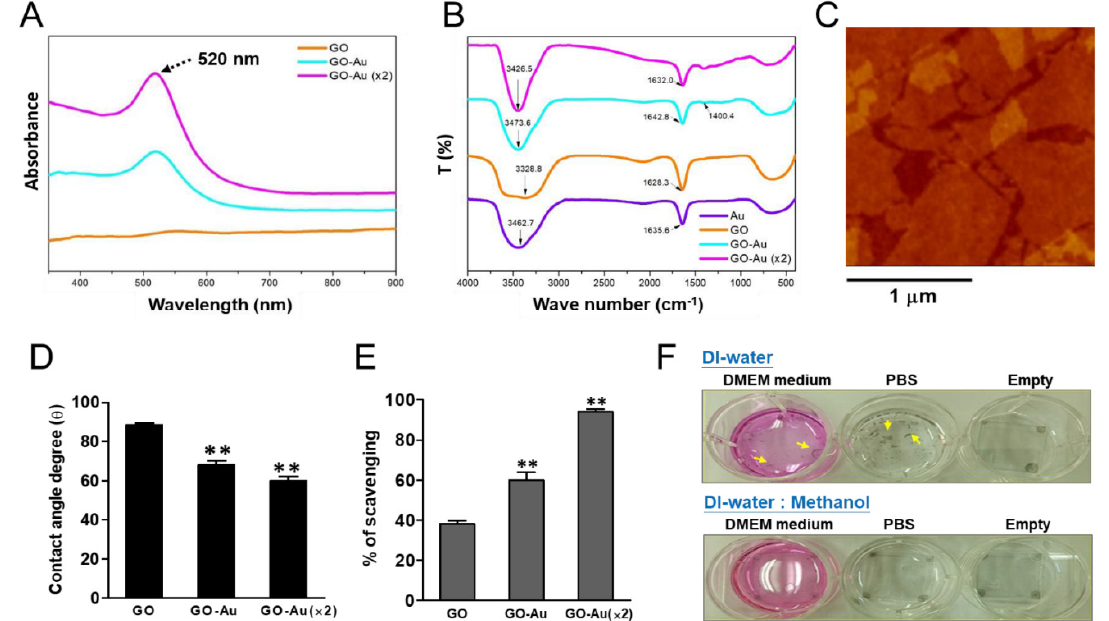
Figure 1. Characterization of as-fabricated Au-decorated GO nanocomposites. Three as-fabricated nanocomposites including GO, GO-Au, and GO-Au ( × 2) were subjected to analyze: ( A ) UV-Vis absorption spectra, where the peak at 520 nm is the absorption wavelength of AuNPs; ( B ) FTIR spectra; ( C ) AFM image of GO; ( D ) average contact angle ( θ ). The contact angle from different materials without water is θ = 0°. Finally, ( E ) trapping potential for DPPH radical scavenging activity of three as-fabricated nanocomposites was also validated. The data were expressed as means ± SD of three independent experiments. ** p < 0.01. To validate the GO effectively stabilized on the glass substrates, first, GO was well-dispersed in either ( F ) DI-water or DI-water/methanol (MeOH) mixture solution (1:1, v / v ) and then spin-coated onto glass substrates (cover slides). Next, these samples were placed on culture plates and soaked in different solutions including DMEM culture medium, PBS, and without solution (empty). Small pieces of GO film were suspended (indicated as yellow arrows), whereas well-coated and stabilized GO film was found.